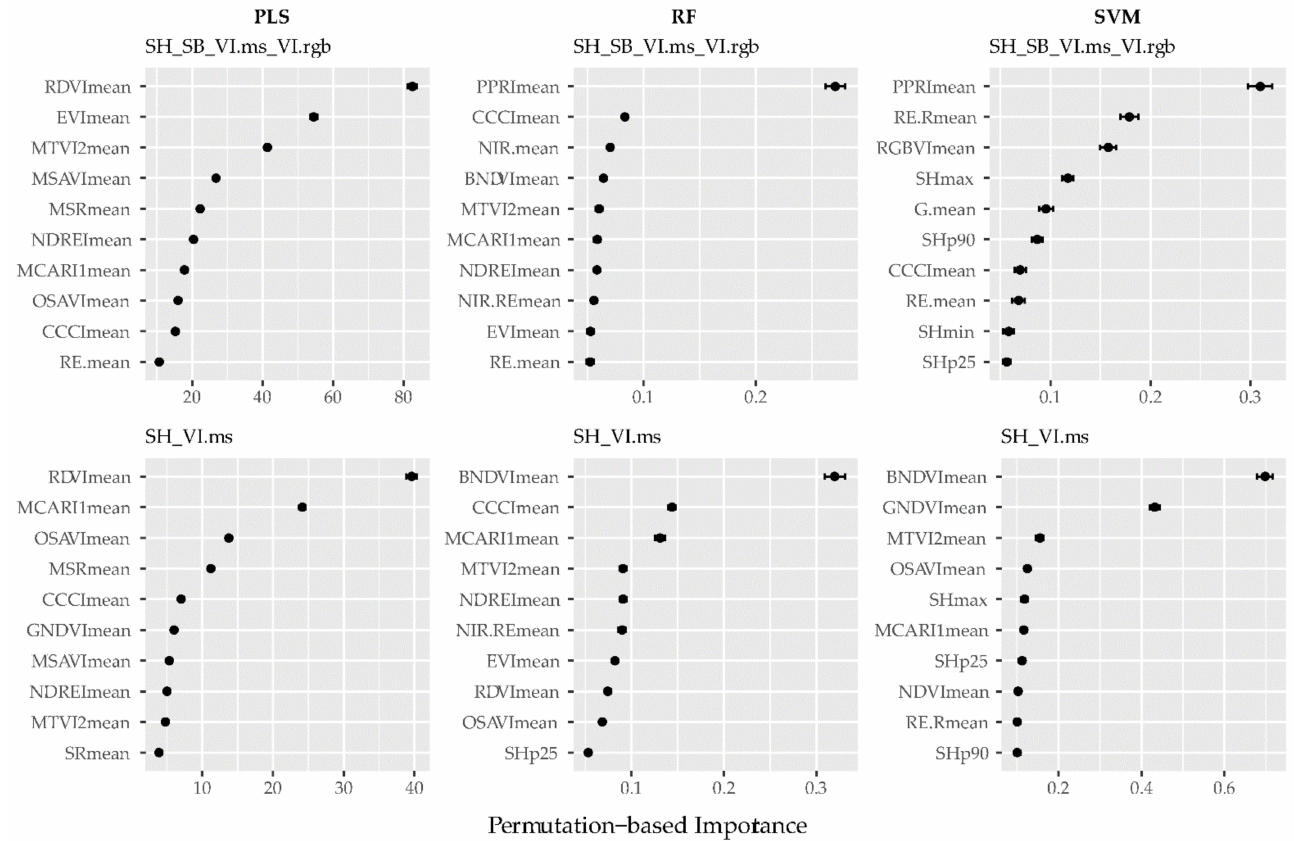
Figure 16. Variable importance plots of best models (10 most important variables shown) for N%